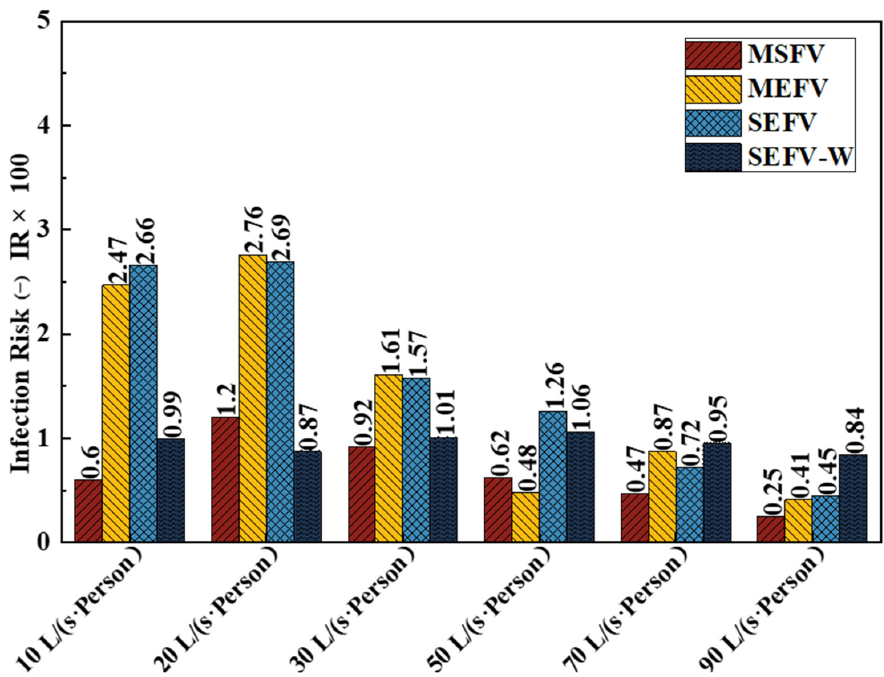
Figure 14. Infection risk to medical staff wearing N95 masks under the four ventilation strategies with different ventilation rates.